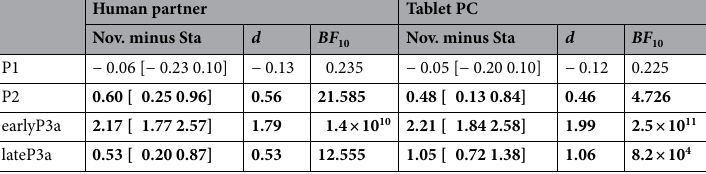
Table 3. Novel minus standard difference mean component scores of the PCA components including [95% CI], Cohen’s d effect size, and Bayesian t test BF 10 . Relevant results are marked in bold.